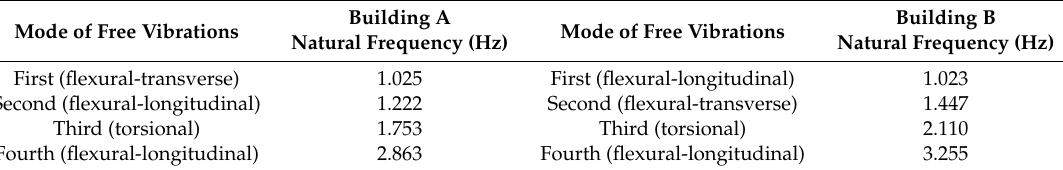
Figure 7. Modes of free vibrations for building B. Table 2. Natural frequencies determined for models of buildings.